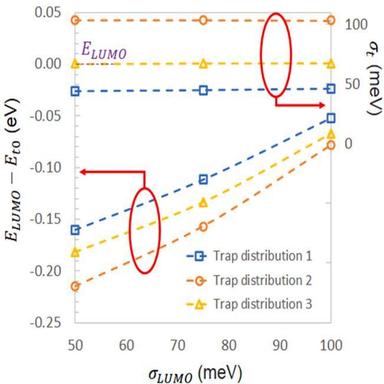
Evolution of the trap parameters extracted from the Q-DLTS spectra with the intrinsic DOS width σLUMO.